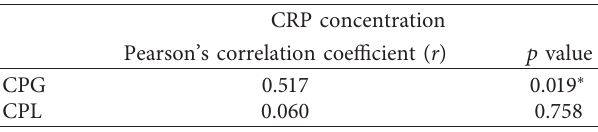
Table 3: Association of the proportion of teeth with ≥ 5mm PD with the CRP concentration in the CPG and CPL groups.